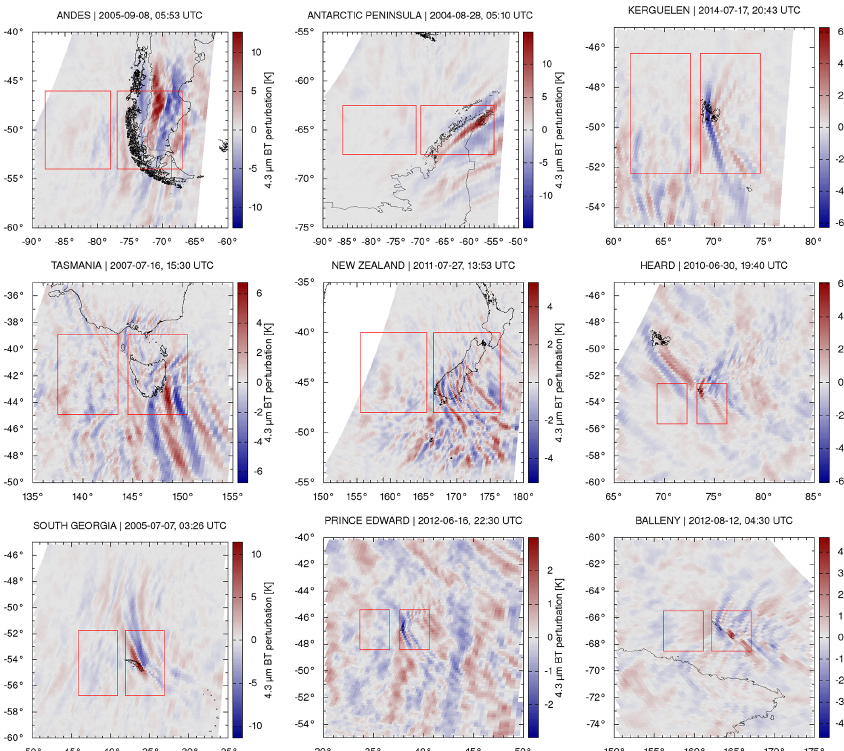
Figure 3. Maps of 4.3µm brightness temperature perturbations from individual AIRS/Aqua satellite orbits illustrate stratospheric gravity wave activity at selected orographic hotspots. Red boxes indicate the eastern and western boxes used to detect gravity wave